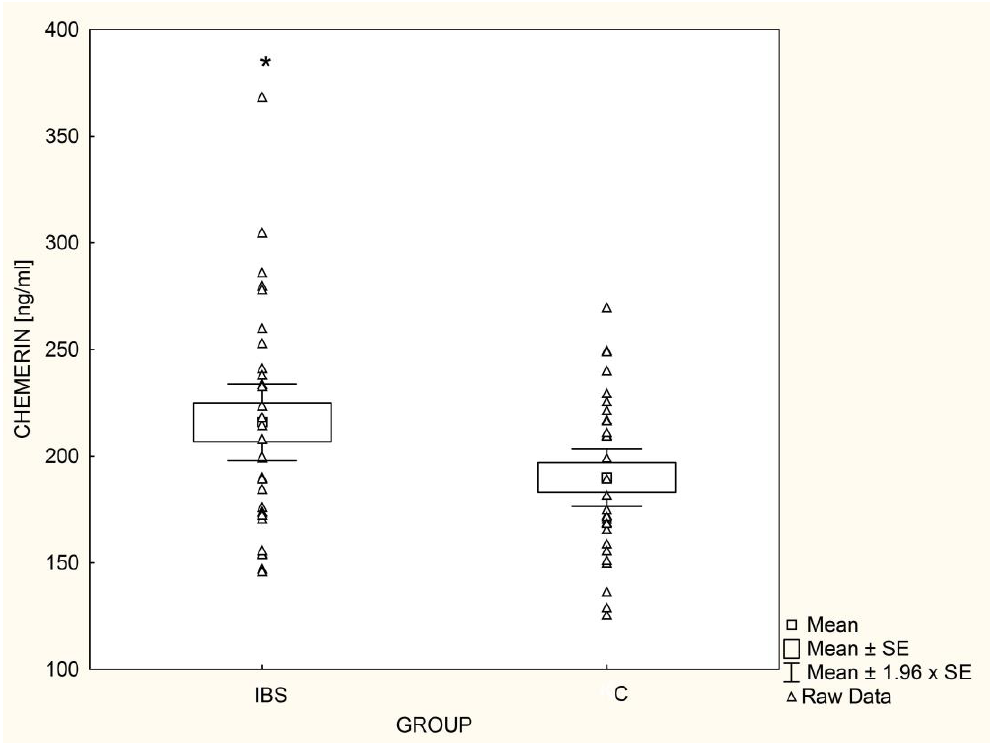
Figure 3. Mean chemerin levels in children with irritable bowel syndrome (IBS; n = 33) and controls (C; n = 30), * p = 0.03.